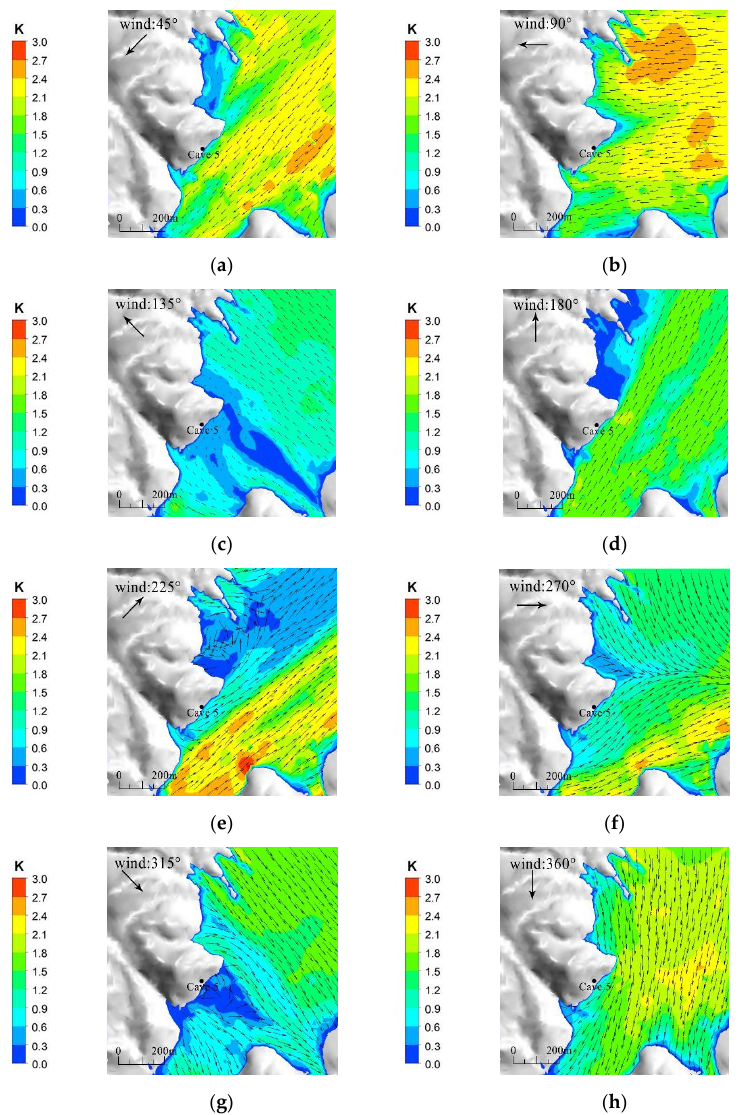
Figure 15. Contours of the simulated wind speed ratio in a horizontal plane at Cave 5 height for the inlet wind directions of 45° – 360°. ( a ) 45°; ( b ) 90°; ( c ) 135°; ( d ) 180°;( e ) 225°; ( f ) 270°; ( g ) 315°; ( h ) 360°.